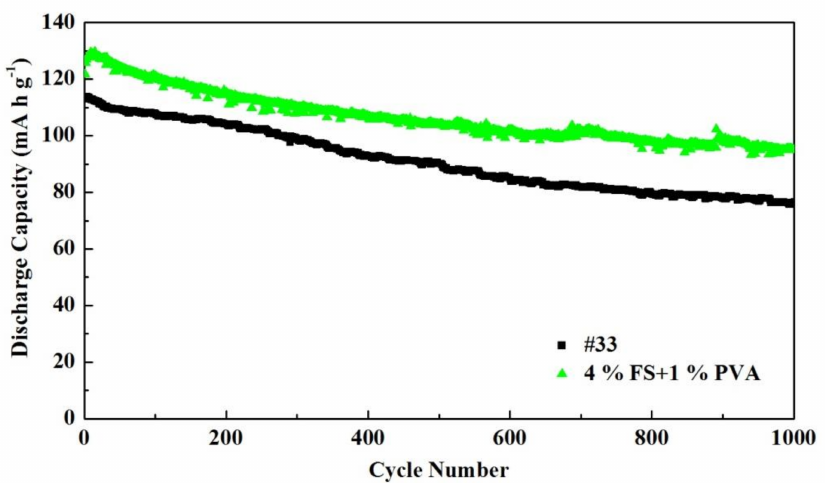
Figure 4. Cyclability of the 4% FS + 1% PVA and the reference coin cell.